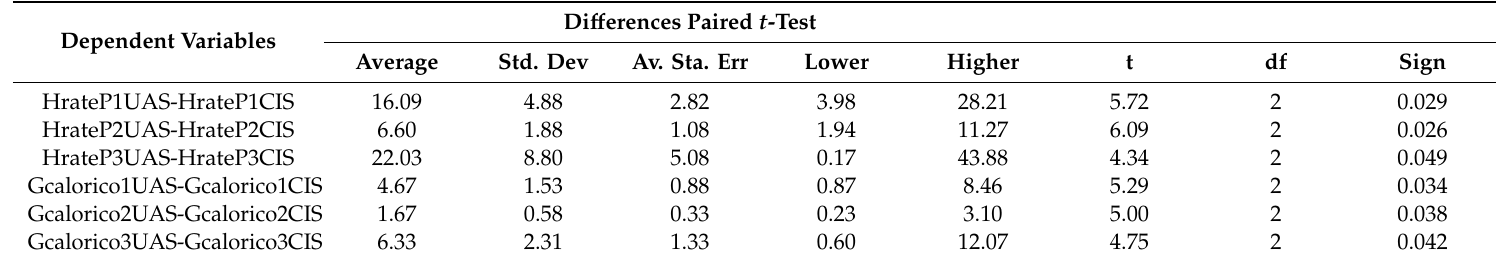
Table 2. t -Test for paired HR and caloric expenditure variables according to the scenario (pilot study).